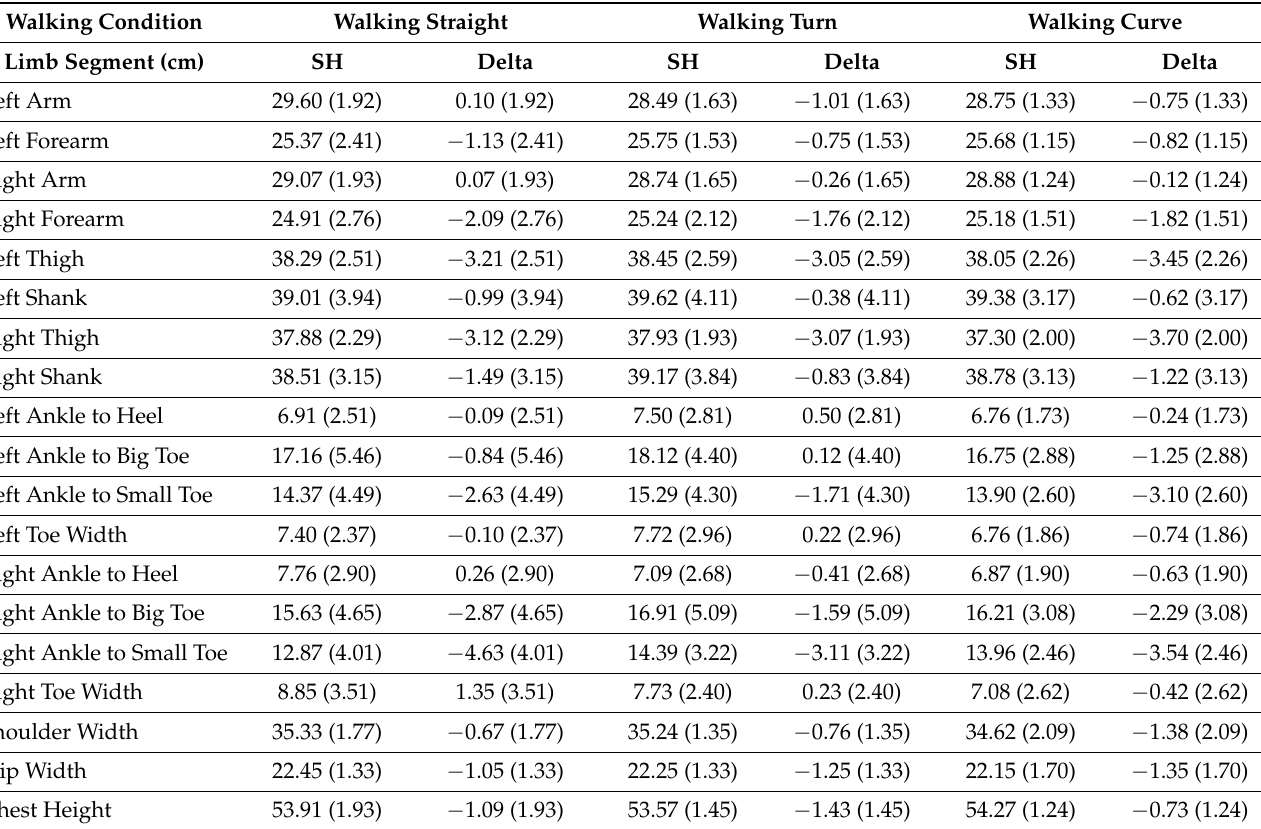
Table 4. Body-segment lengths for participant one: walking straight, walking turn, and walking curve test conditions (mean and standard deviation in brackets). Smart Hallway (SH) values were calculated using the 3D reconstructed data, and Delta is the difference between the Smart Hallway and ground-truth segment lengths.